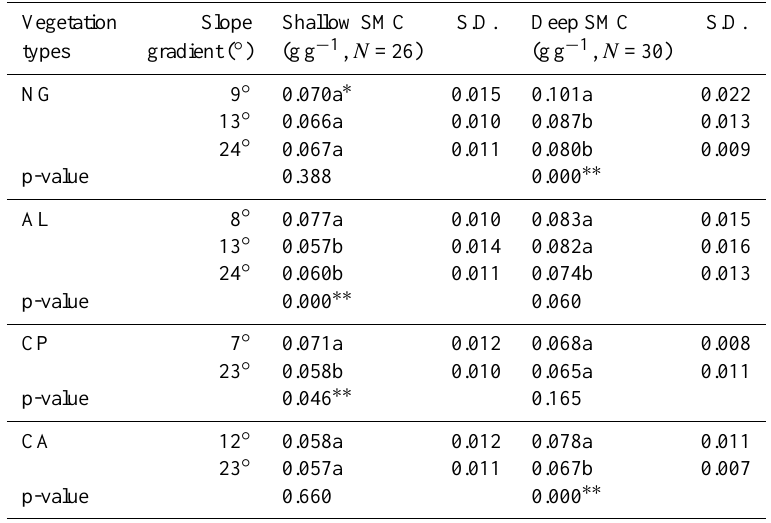
Table 4. Temporal- and depth-averaged shallow SMC and depth-averaged deep SMC in different slope gradients together with F-test and t-test.